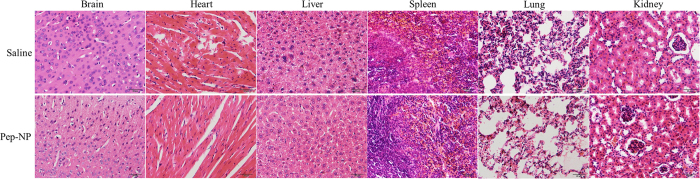
Histochemistry analysis of organs (brain, heart, liver, spleen, lung and kidney) stained with H&E of ICR mice 24 h after i.v. administration of 100 mg/kg blank Pep-NP for 6 days, one dose per day, and saline as control.